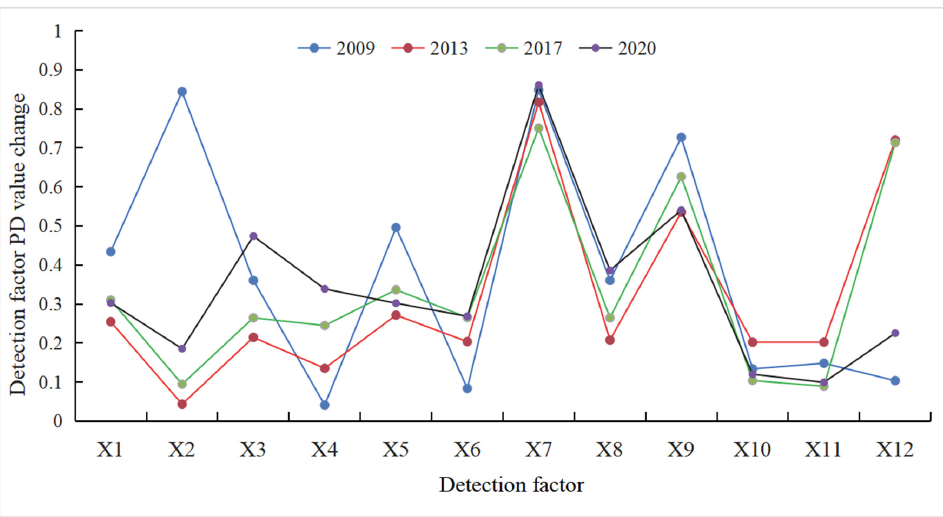
Figure 5. Change in PD value of detection factor in Seven Star Pass area from 2009 to 2020. X1, per capita GDP; X2, average GDP; X3, urbanization rate; X4, population density; X5, total population at end of year; X6, total industrial output; X7, total fixed assets investment of whole society; X8, total annual wages of employees per unit; X9, total fiscal revenue; X10, average slope; X11, average elevation; X12, road network density.